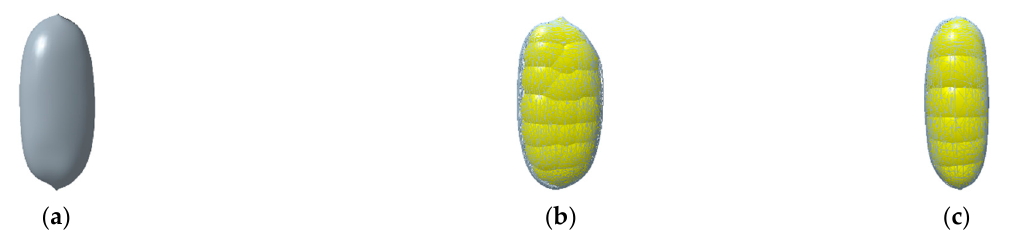
Figure 5. Rice grain model: ( a ) scanning model; ( b ) front filling of discrete element model; ( c ) side filling of discrete element model.